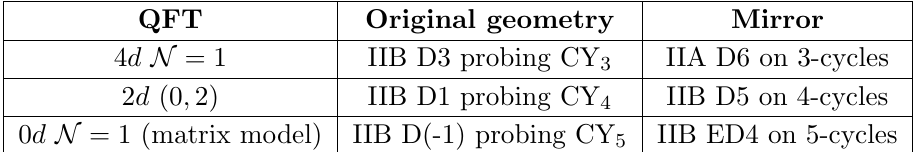
Table 1 . Con(cid:12)gurations of D-branes giving rise to quantum (cid:12)eld theories in various dimensions. surface f ( w; x; y; z ) = 0, from which stacks of Euclidean D3-branes are suspended.